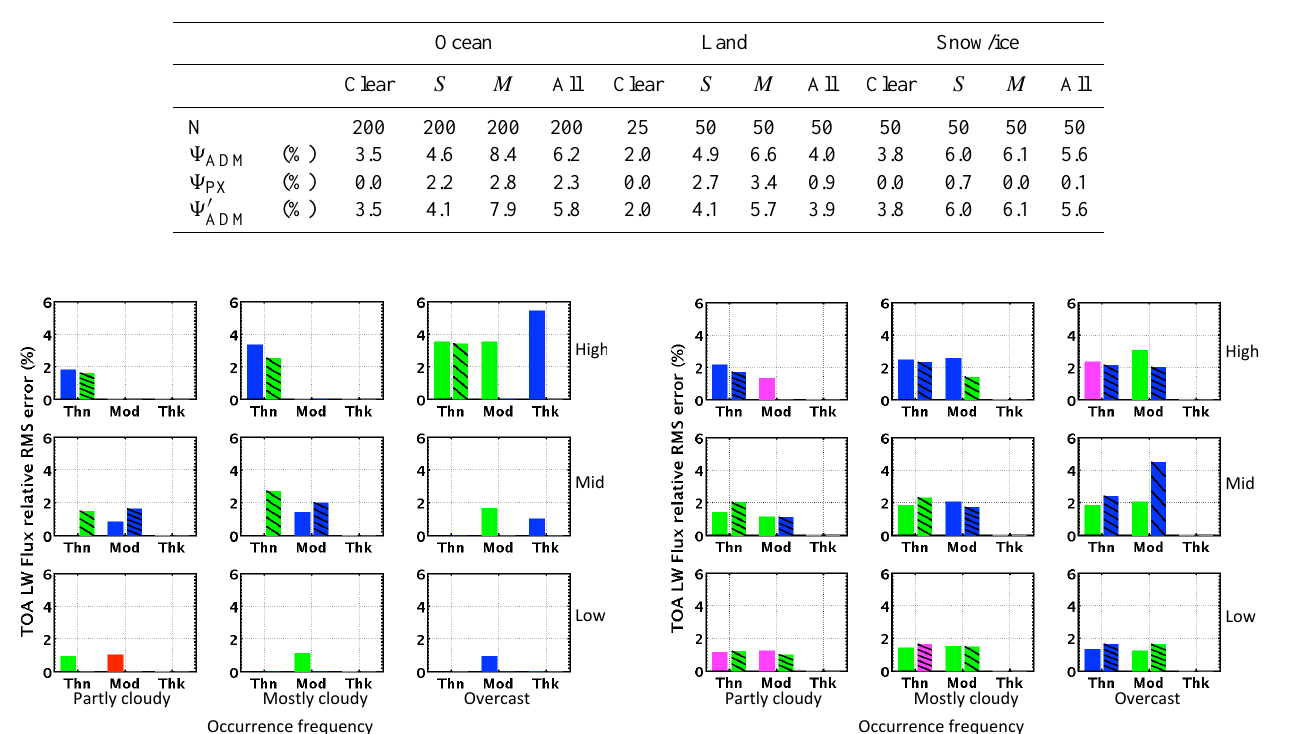
Table 6. Flux consistency due to ADM uncertainty using MISR measurements for clear-sky, single-layer cloud ( S ), multi-layer cloud ( N ), and all-sky conditions over three surface types. N is the minimum sample number required to derive the regression coefficients; (cid:57) ADM is the relative consistency due to ADM uncertainty before removing the parallax effect; (cid:57) PX is the contribution of parallax effect to the total consistency; (cid:57) (cid:48) is the relative consistency due to ADM uncertainty after removing the parallax effect. ADM